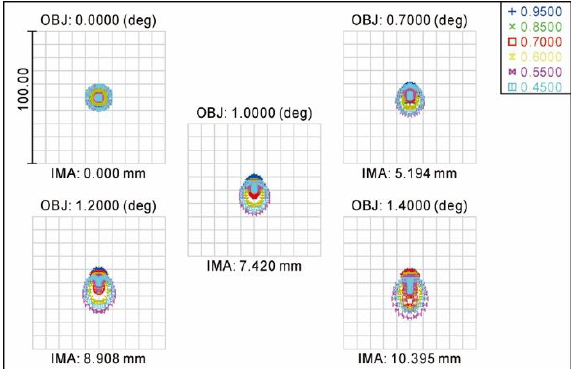
Figure 4. Spot diagram of diffuse spots. Table 5. Radii and centroid localization accuracies of diffuse spots.